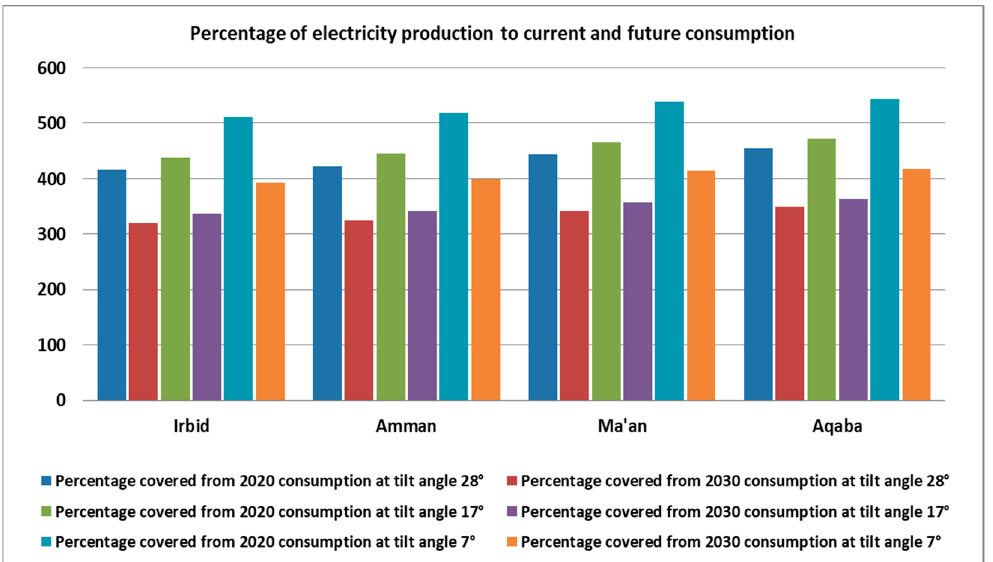
Figure 11. A comparison between electricity production from the installation of PV systems on the rooftops of villas in relation to its current and future energy consumption.